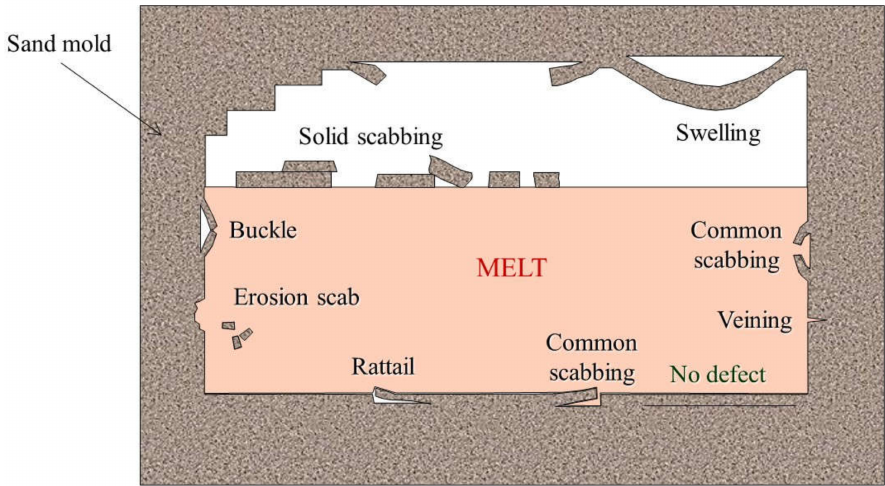
Figure 31. Schematic of defects related to silica expansion according to their formation process.